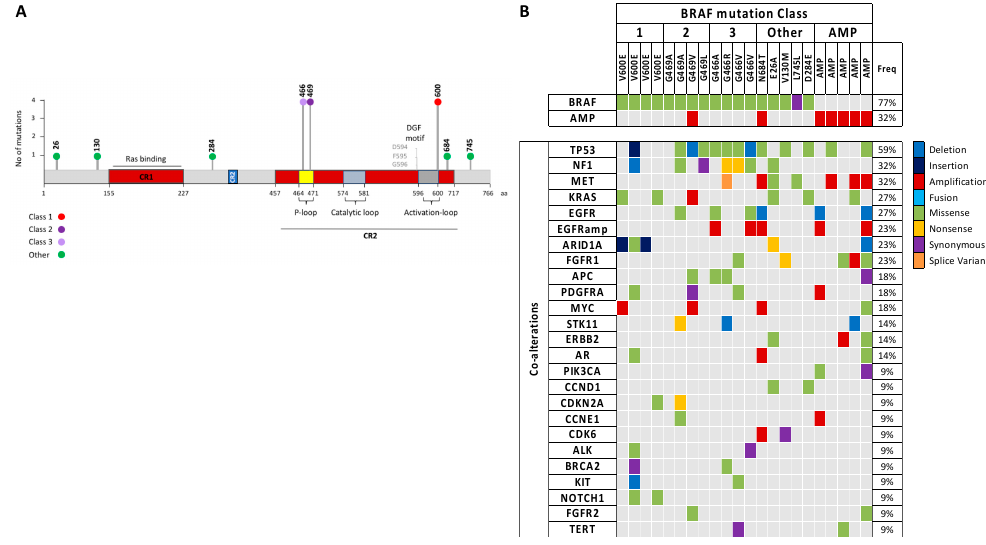
Figure 1. ( A ) Lollipop plot from the plasma cfDNA sequencing results, representing the classification of the detected BRAF mutations ( n = 17). Class I, II, and III mutations are indicated in red, purple, and lilac, respectively, and “other” mutations are indicated in green. Amplifications are not depicted in this plot; ( B ) OncoPrint representing the most common co-alterations detected in the BRAF -alteration positive cohort. Individual samples are represented as columns and grouped by BRAF class, while individual genes are represented as rows. The alterations are represented as follows: deletion (blue), insertion (navy blue), amplification (red), fusion (turquoise), missense mutation (green), nonsense mutation (yellow), synonymous mutation (purple), and splice variant (orange). cfDNA: cell-free DNA; AMP: amplification; Freq: frequency.